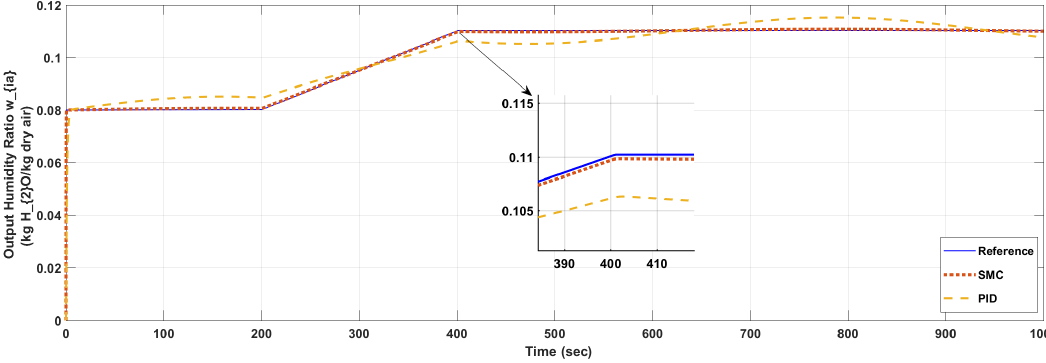
Figure 8. Output humidity response of controllers while tracking sequence of steps and ramp